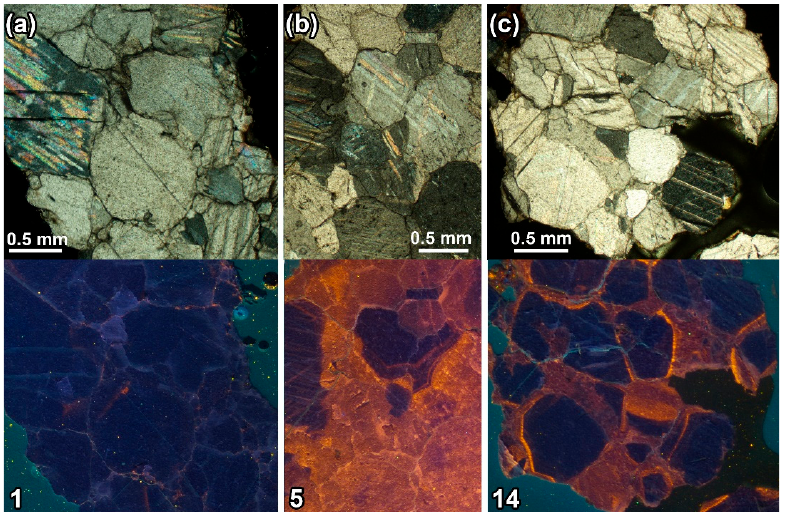
Figure 2. Petrographic images of three representative sampled marble fragments ncluding XPL (top) and CL (bottom) micrographs of the same areas using an exposure time of 15 s. ( a ) sample 1; ( b ) sample 5; ( c ) sample 14. Table 2. List of the main petrographic characteristics and isotopic ratios (V-PDB ‰) corresponding to the measured samples. Textural qualifiers are Hom: homogeneous; Het = heterogeneous; Mor = mortar; Mot = mottled; Bo = boundary grains; MGS is maximum grain size; MFS is most frequent grain size range. GBS is grain boundary shape, C = curved or E = embayed. CL is cathodolumines- cence; LL (very low)/L (low)/M (medium).